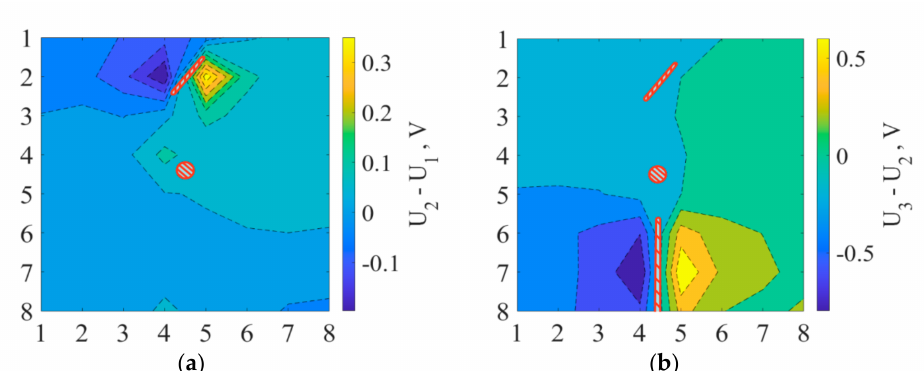
Figure 12. Experimentally obtained voltage distribution difference between the cases (2) and (1) ( a ), cases (3) and (2) ( b ). Damaged areas are red line highlighted. Vertical and horizontal numbers from 1 to 8 define the coordinates of electrodes on the composite